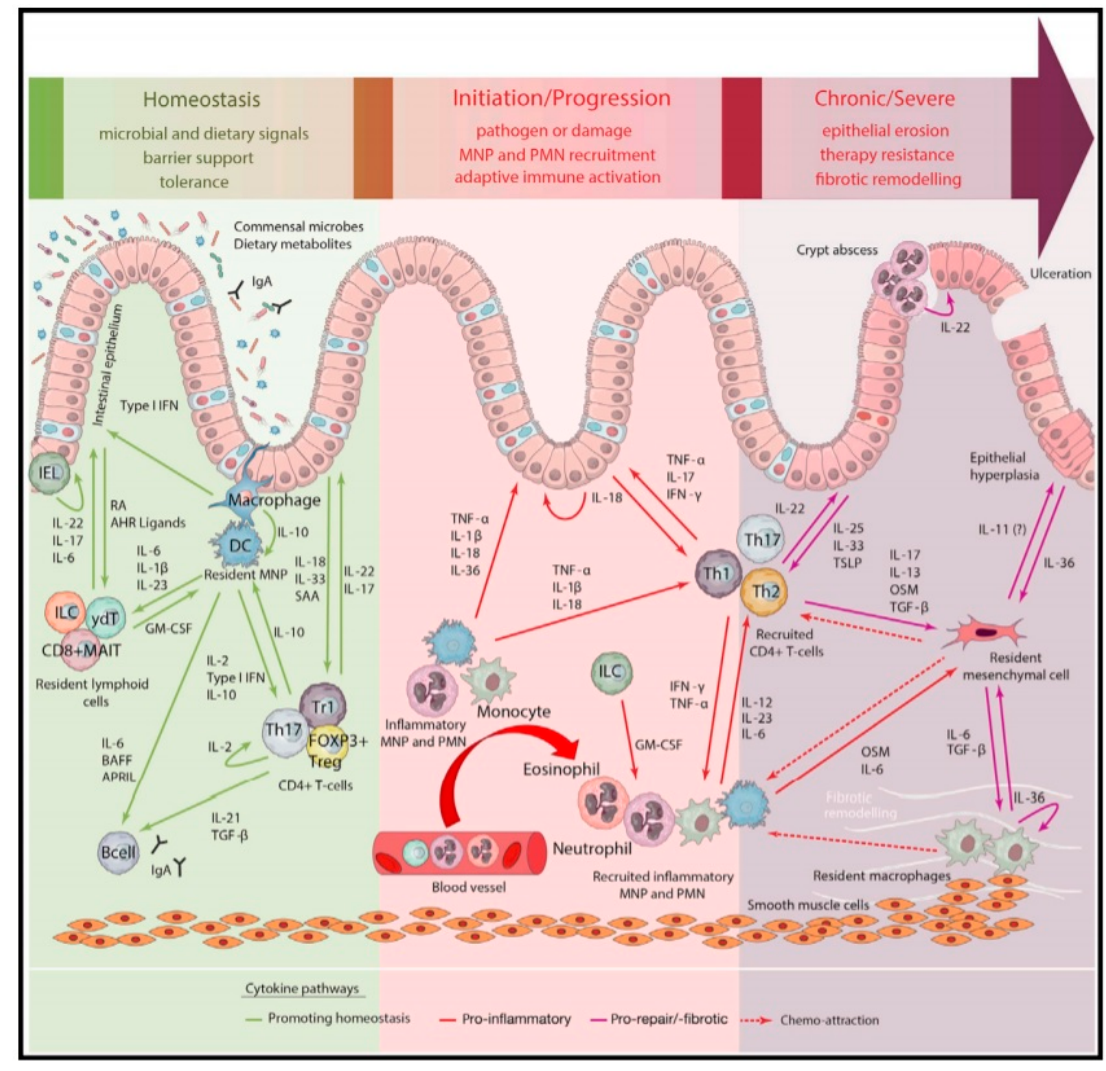
Figure1. Mucosalimmunologyofthegastrointestinaltract(GIT)underhomeostasis, acuteinflammation and chronic inflammation in inflammatory bowel diseases (IBD). The aberrant immunological response of the innate immune system induces an acute inflammatory state that may progress to chronic inflammation with a prominent role of the adaptive immune system. The involved cytokine network is complex and shows a major role of the proinflammatory cytokine tumor necrosis factor- α (TNF- α ). For an explanation and overview of all the abbreviations, the reader is referred to the original work of this Figure [4]. Reprinted from Friedrich et al. [4] with permission from